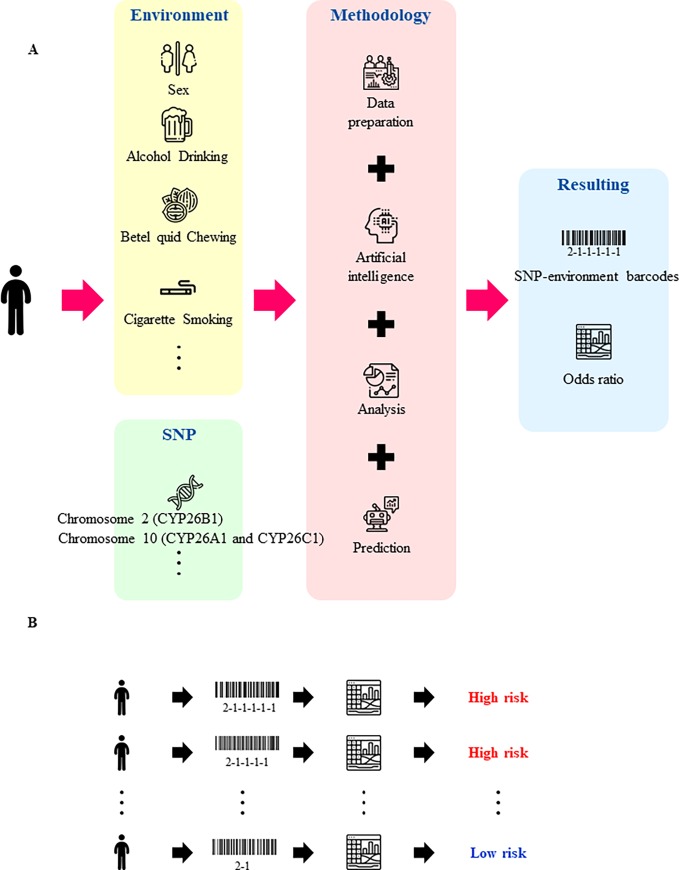
Application of simulation-based novel SNP-environment barcodes for evaluating the occurrence of oral malignant disorders by odds ratio-based BPSO.(A) After calculating and analysis statistically by BPSO, we render combined associations of each high-risk group from SNP-environment data. (B) SNP-environment data can be converted to create barcodes (e.g., 2–1, 2-1-1-1-1, and 2-1-1-1-1-1) from each subject and render them prone to the low and high risk group of oral malignant disorders. ICONs are designed by Freepik (https://www.freepik.com/).